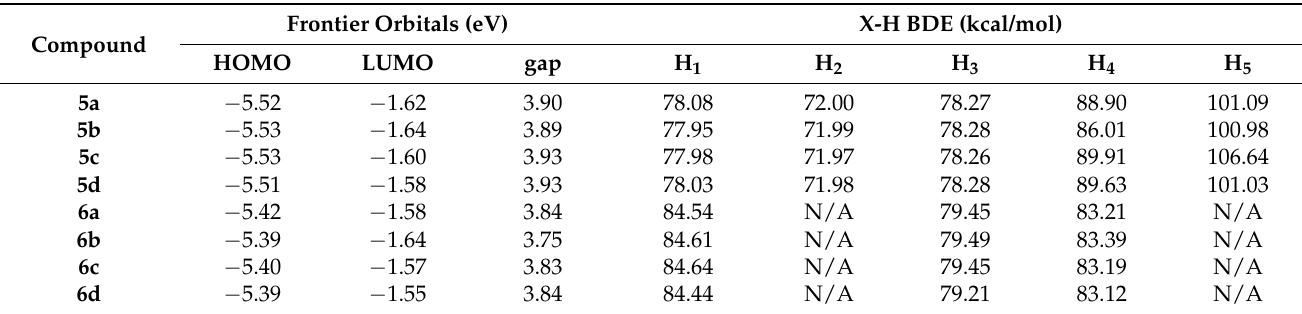
Table 7. The energy of the frontier orbitals and the BDE for the H 1 -H 5 sites in 5a – d and 6a – d compounds, according to the numeration presented in Figure